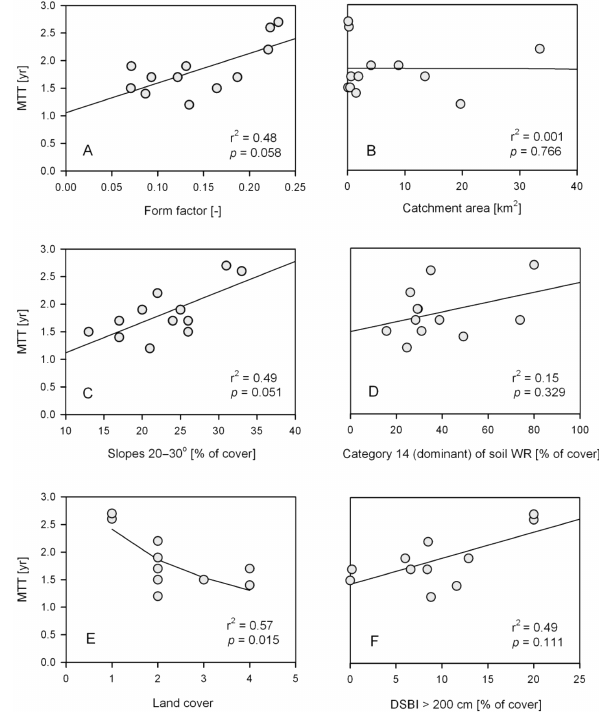
Figure 5. Regressions between stream baseflow MTTs and topo- graphic features, subsurface properties, land cover, and catchment area for the study